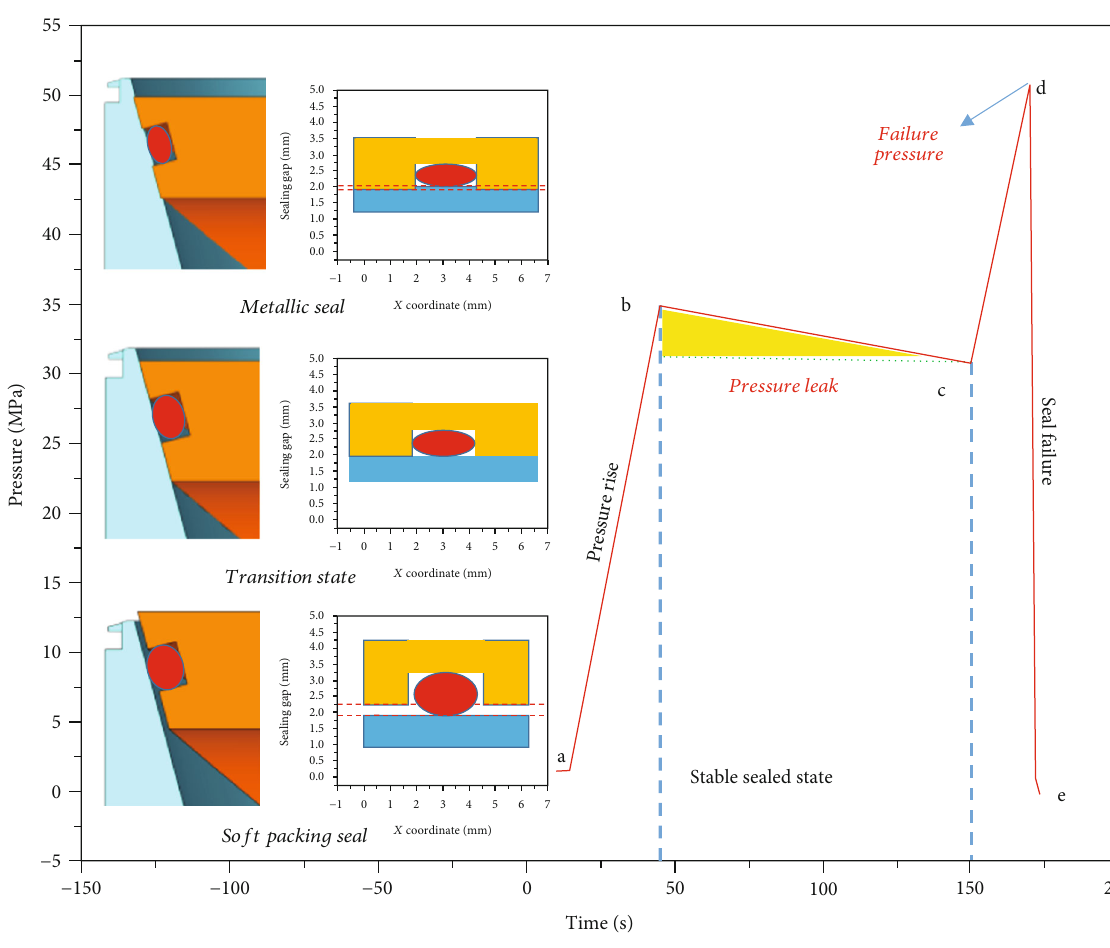
Figure 2: Sealing state and pressure change